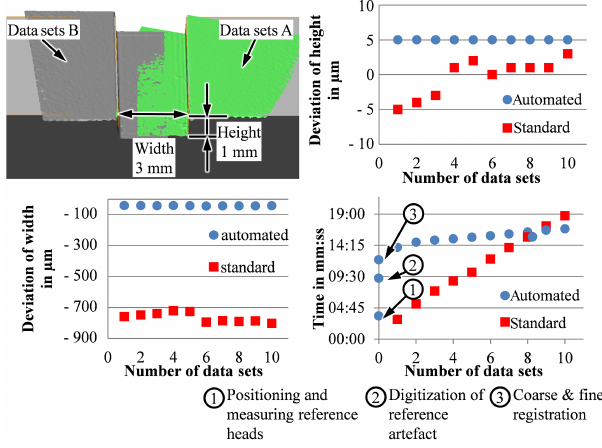
Figure 8. Considered parameters for comparing the standard mea- suring procedure (standard) and the automated measuring proce- dure (automated) with the new qualification concept (upper left cor- ner). Results for deviations of height (upper right corner), width (lower left corner) and comparison of needed time (lower right cor- ner).